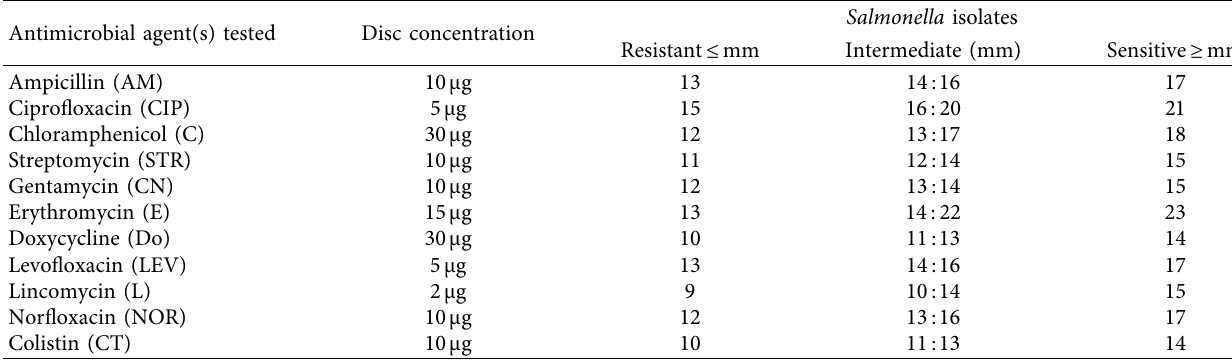
Table 2: Breakpoint values of each antimicrobial agent according to [36].